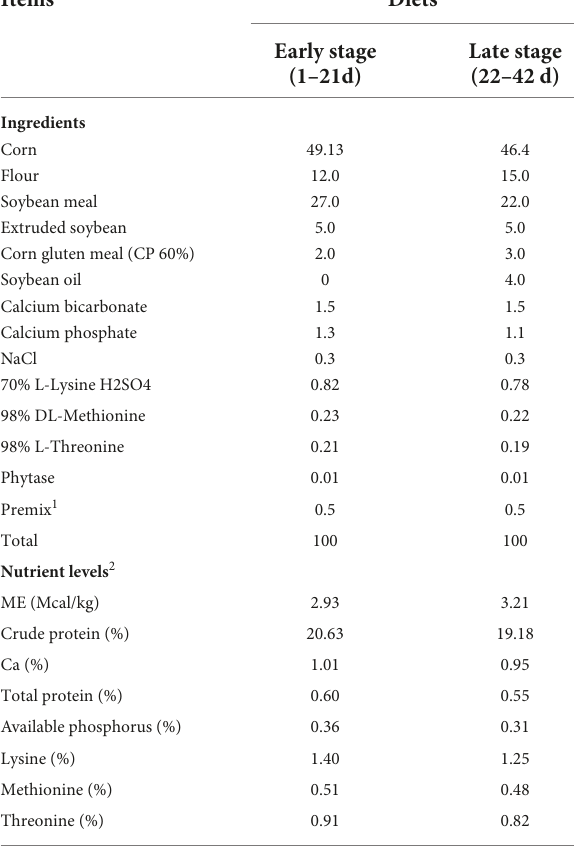
TABLE 1 The composition and nutrient levels of diets (air-dry basis,